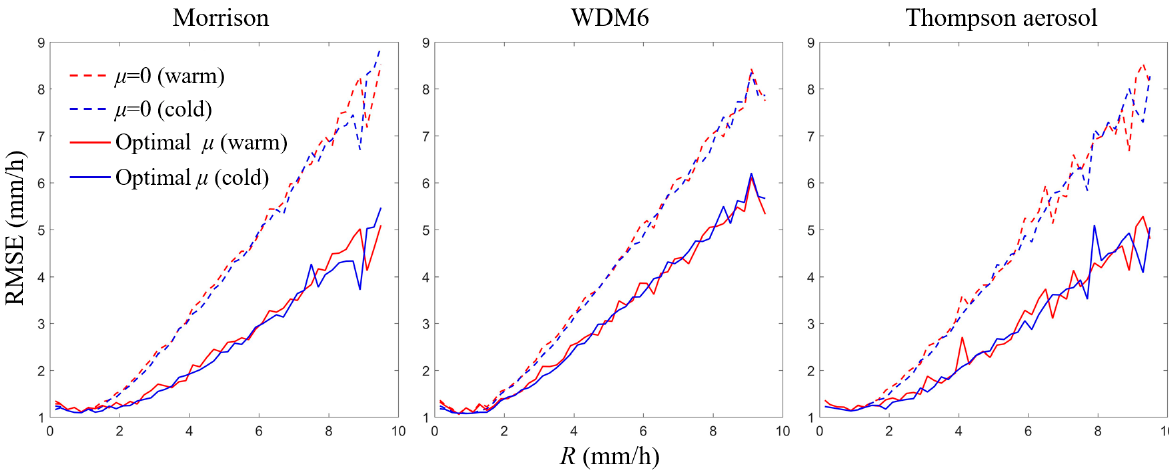
Figure 7. Root-mean-square errors (RMSEs, mm/h) of fixed- and optimal- μ gamma RSD models in WRF rainfall retrieval for different seasons and double-moment schemes.